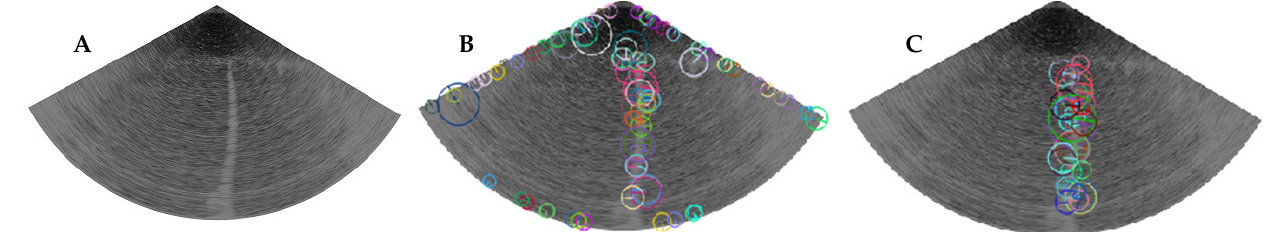
Figure 17. Using SURF directly to detect the target. ( A ) is the original image, ( B ) is the SURF detection result of ( A ), and ( C ) is the SURF detection result of ( A ) with restrictions on feature scale and direction.